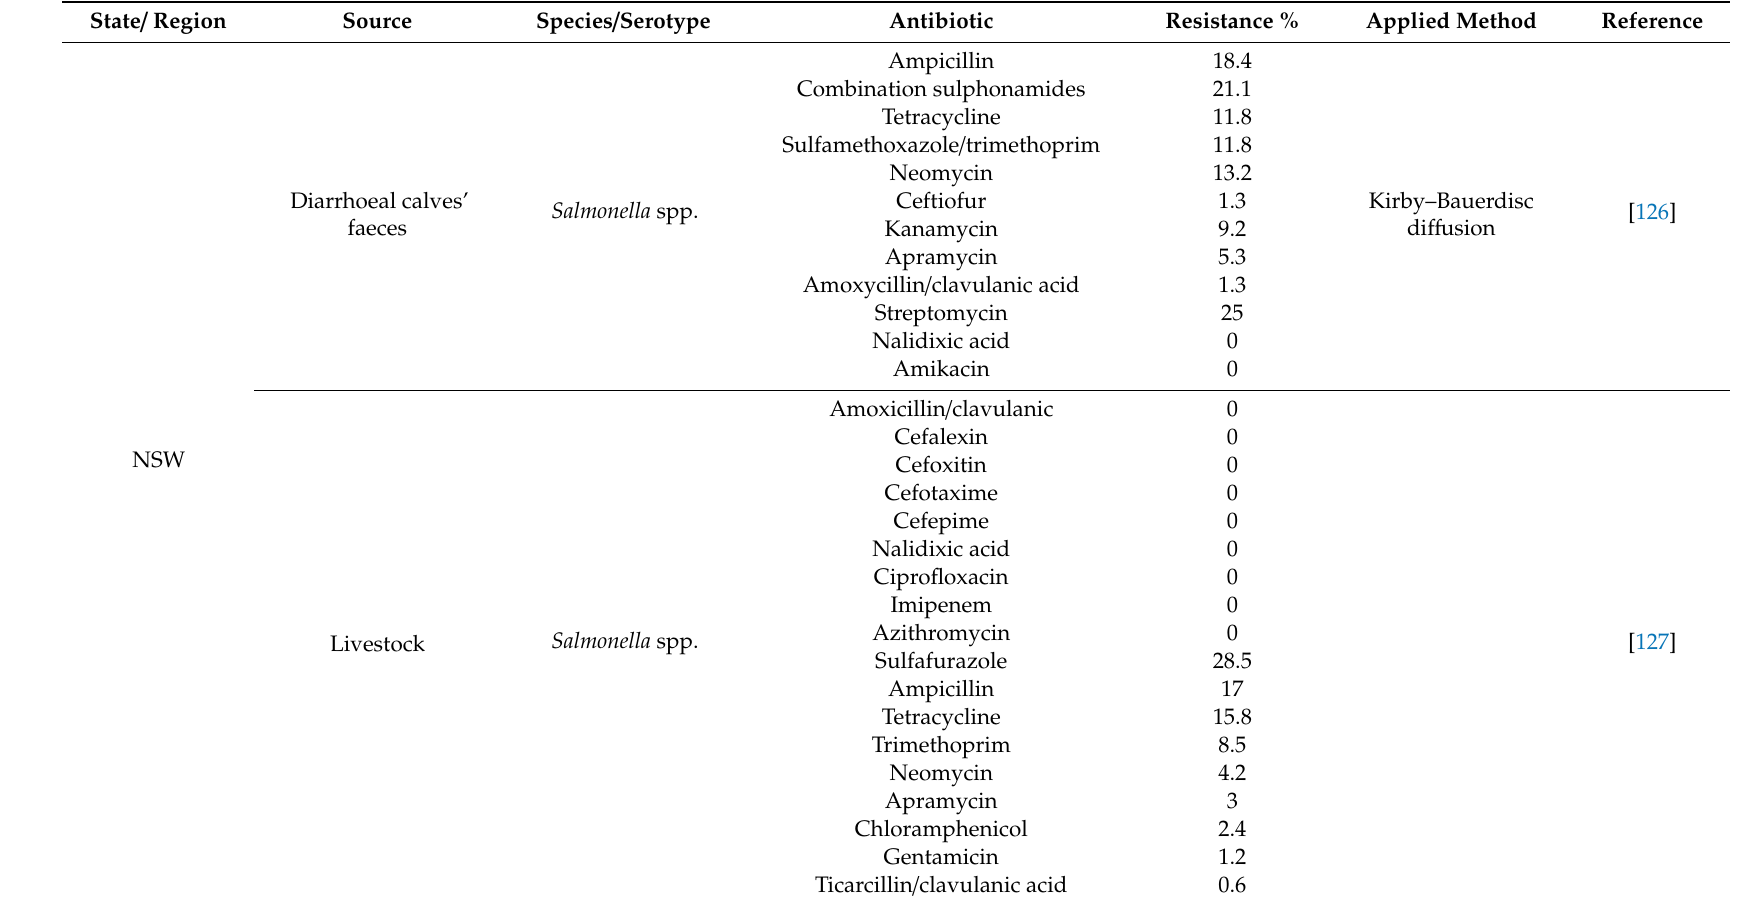
Table A3. Antimicrobial resistance of non-typhoidal Salmonella isolated at the human–food interface of